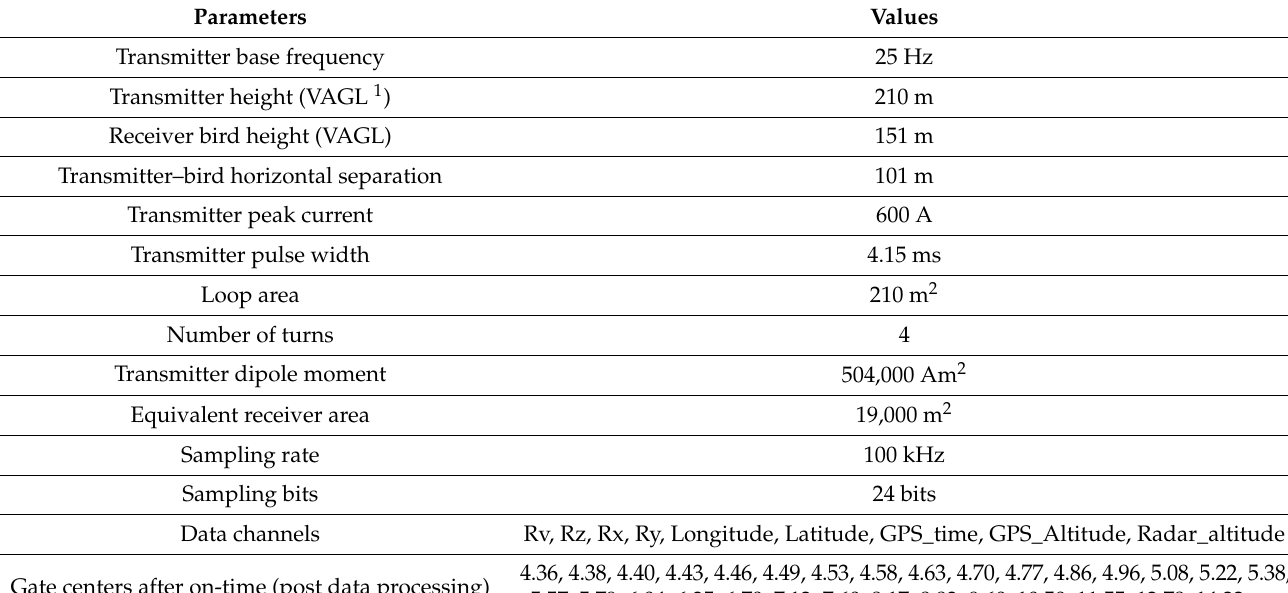
Table 2. iFTEM-I system parameters for the test flight in